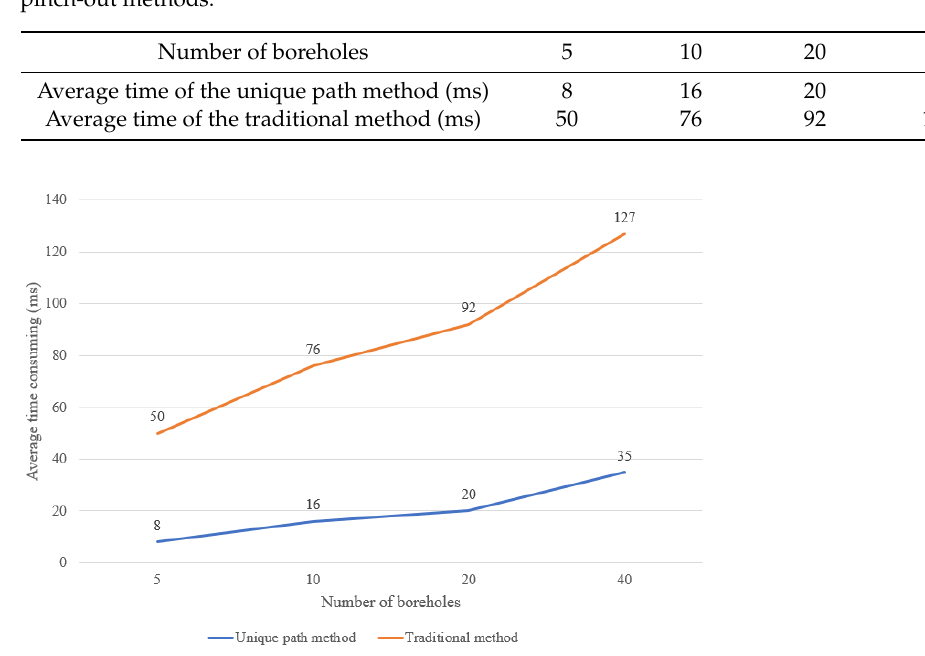
Table 4. Comparison between the computation times of the proposed method and that of other pinch-out methods.